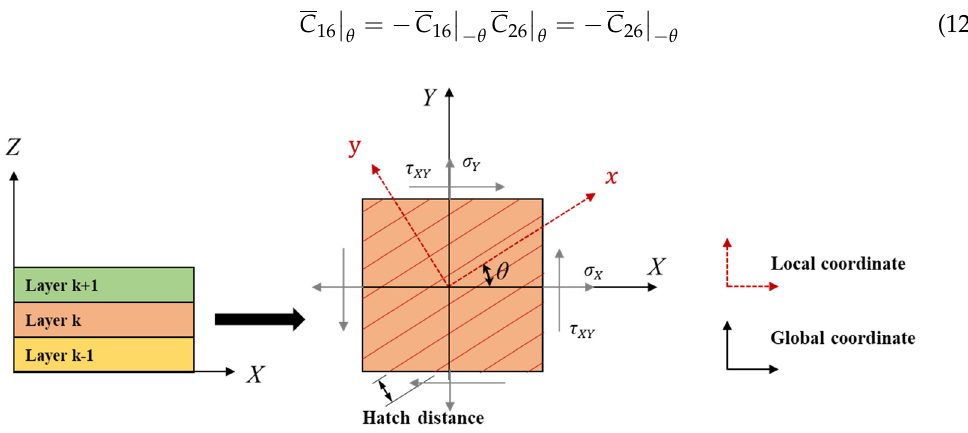
Figure 2. Schematic of the layer’s local coordinate system.